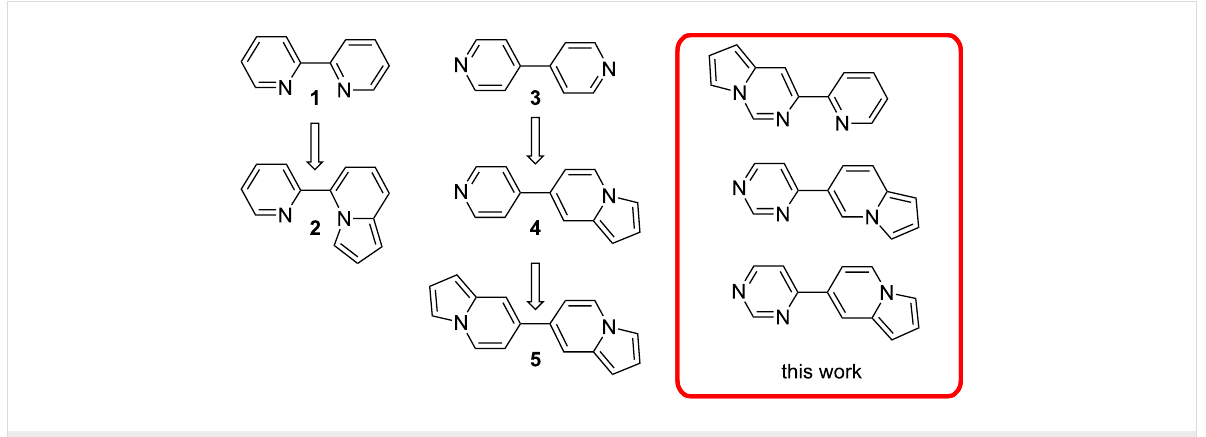
Figure 1: Examples of hybrid heteroarenes from the class of indolizines.